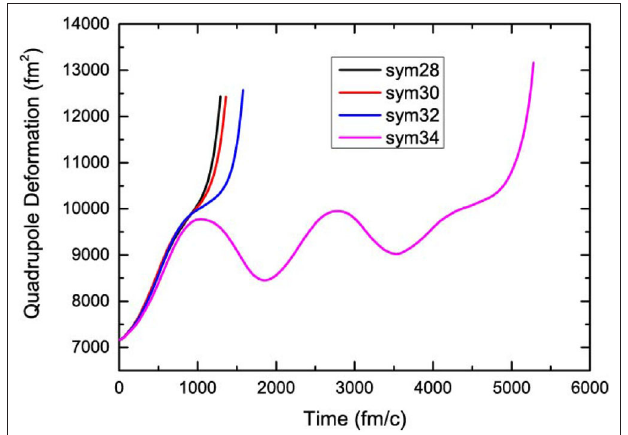
FIGURE 4 | The TDHF evolutions of quadrupole, octupole, and hexadecapole deformations of the heavy fragment after the 240 Pu fission with the SV-sym32 force.